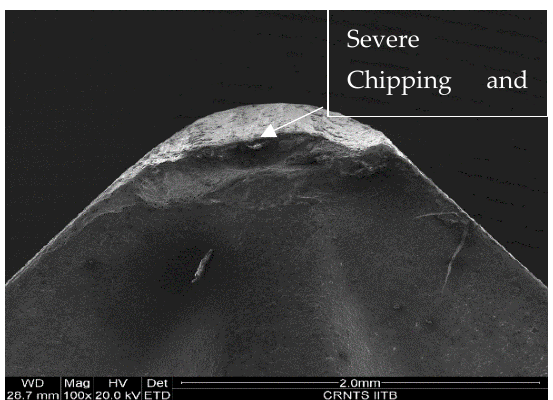
Figure 2. Crater wear with the initial recommended/used parameters.